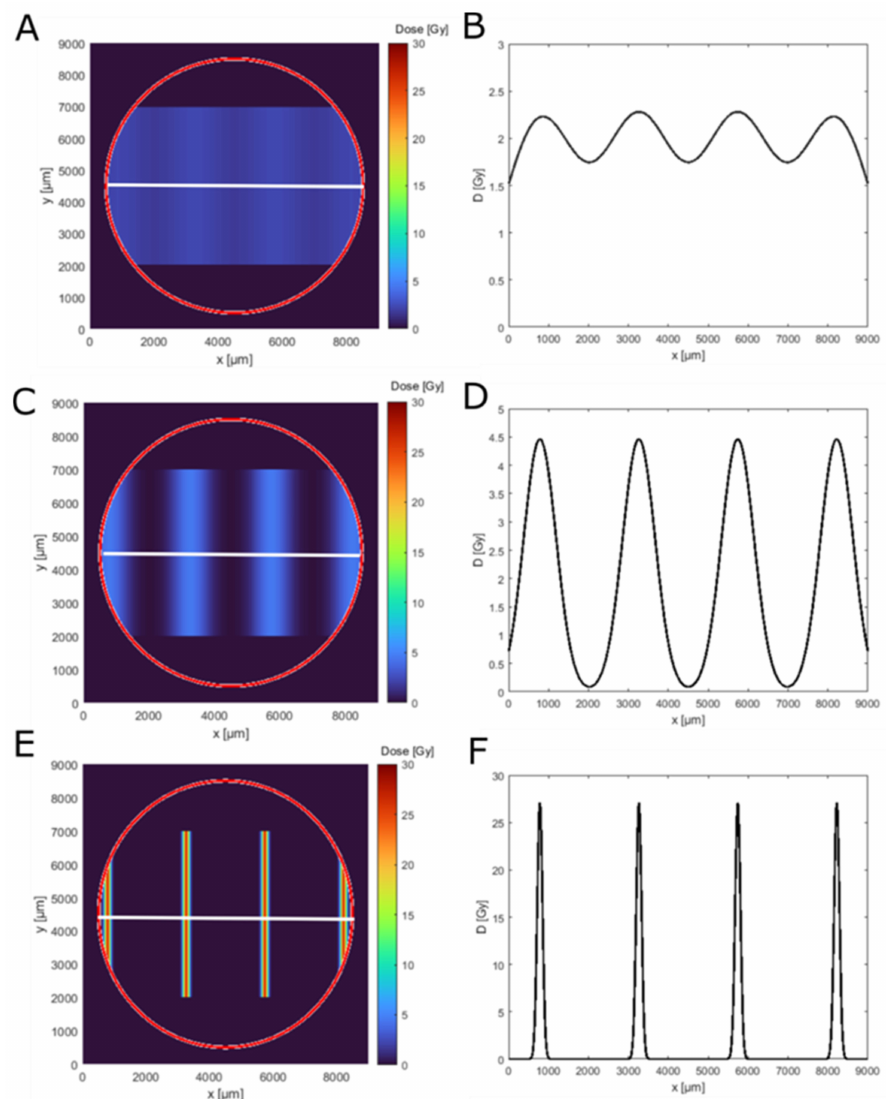
Figure 2. Dose simulation for the used minibeam irradiation geometries on an epidermis model. Panels ( A , C , E ) show the 2D dose distribution (top view) in the epidermis model insert outline (red circle) for 920 µ m, 408 µ m and 66 µ m beam width. Panels ( B , D , F ) show the corresponding simulated dose distribution along the white line in the top view ( A , C , E